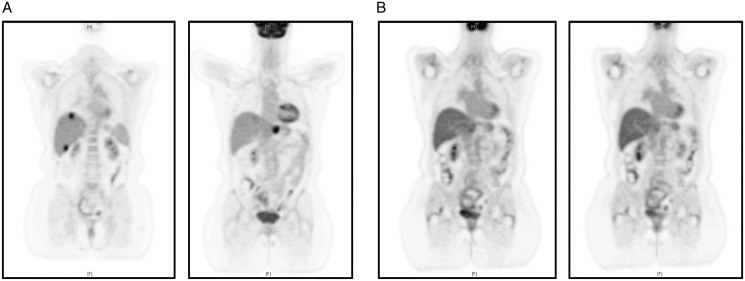
[18F]2-fluoro-2-deoxy-D-glucose positron emission tomography (FDG-PET) imaging. (A) FDG-PET imaging taken at baseline before initiation of larotrectinib. 2-fluoro-2-deoxy-D-glucose (FDG)-avidity is visible in the primary pancreatic tumour and liver metastases. (B) FDG-PET imaging showing the best overall response of partial response to treatment with larotrectinib. FDG-avidity in previously hypermetabolic pancreatic and liver lesions is resolved.